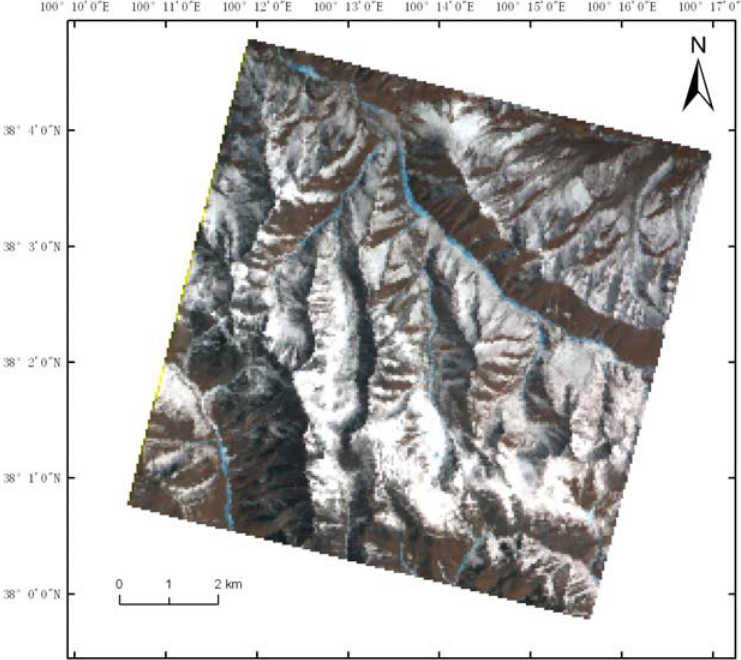
Figure 2. EO-1 Hyperion imagery of the Binggou watershed area (R: band 96, G: band 34, B: band